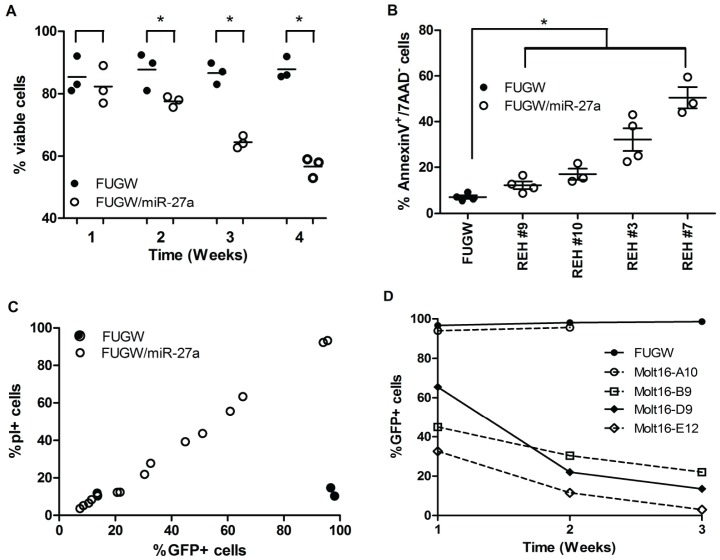
Enforced expression of miR-27a in pre-B-ALLs and T-ALLs.(A) Viability of FUGW and FUGW/miR-27a transduced REH (pre-B-ALL) clonal populations was measured at indicated times as above. Statistical differences in viability over time in FUGW and FUGW/miR-27a K562 colonies were determined by a 1-way ANOVA test (p<0.0001*). (B) REH cells were stained with AnnexinV and 7AAD and FACS-analyzed. Each data point is a replicate for the designated clonal population. Significant differences between FUGW and FUGW/miR-27a clones were compared as above. (C) FUGW and FUGW/miR-27a transduced Molt16 (T-ALL) cells were FACS-analyzed for GFP expression and PI staining. GFP expression positively correlated with PI+ cells in FUGW/miR-27a transduced cells (Pearson r = 0.9965, p<0.0001) compared to FUGW control cells which did not demonstrate this correlation. (D) GFP expression was monitored via FACS over time in FUGW and FUGW/miR-27a Molt16 GFP−/GFP+ mixed populations.